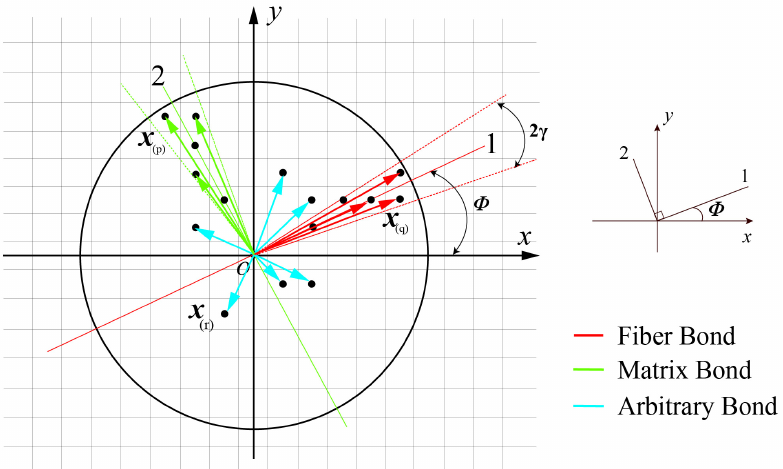
Figure 2. The PD model diagrammatic drawing for a single